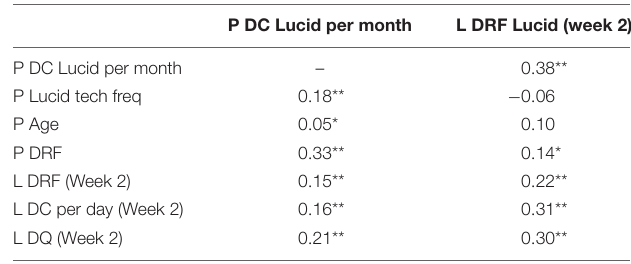
TABLE 3 | Spearman rho non-parametric correlations between pre-test and week 2 lucid dreaming rates and other pre-test and week 2 variables. P DC Lucid per month L DRF Lucid (week 2) P DC Lucid per